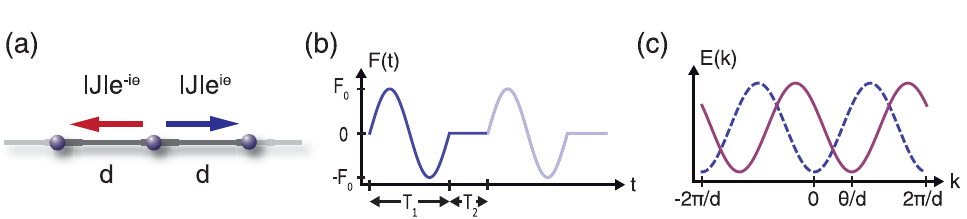
Figure 1. Periodic driving of the 1D lattice. (a) Realised complex tunneling elements on a 1D lattice, with spacing d . (b) Inertial force F of zero mean value resulting from the real space lattice periodic driving. T 1 /T 2 is the asymmetry parameter. (c) Effective single-particle dispersion relation. The presence of a Peierls phase (cid:2) induces a shift of the dispersion relation minimum towards (cid:2) /d (solid line). As a reference, the dashed line represents the dispersion relation in absence of Peierls